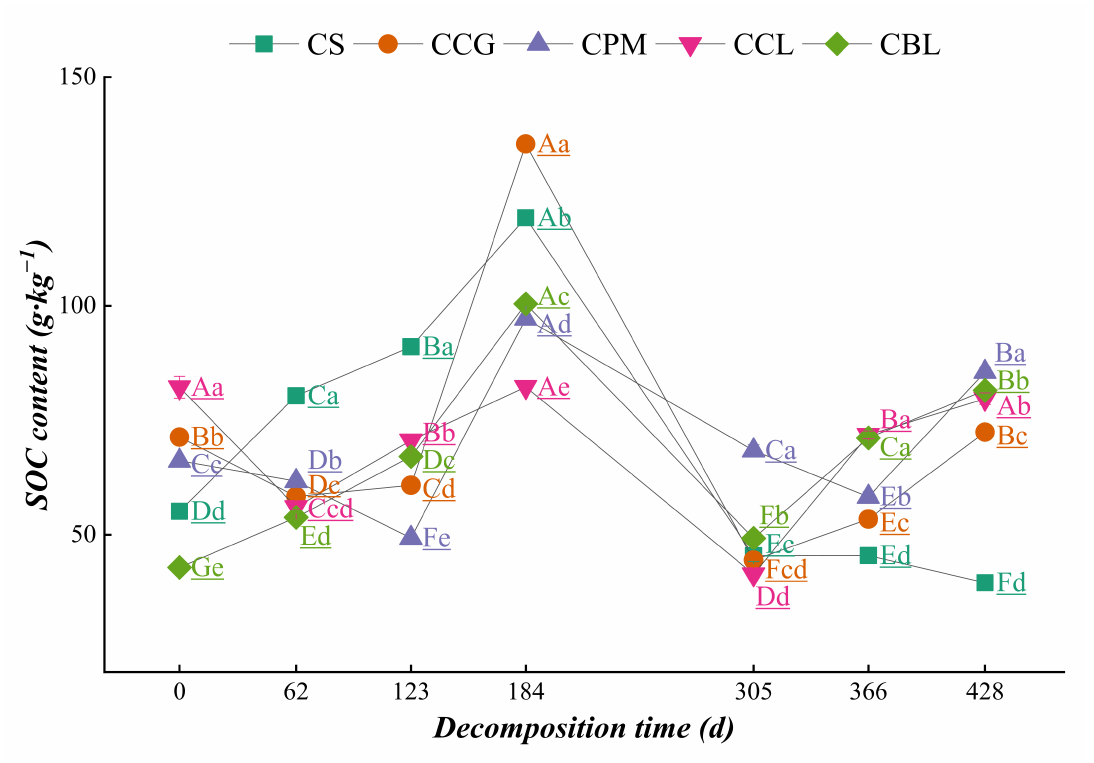
Figure 6. Dynamic changes in the SOC contents of different plant residues during decomposi- tion. Note: A, B, C—differences between decomposition stages of the same treatment ( p < 0.05); a, b, c—differences between treatments in the same decomposition period ( p <